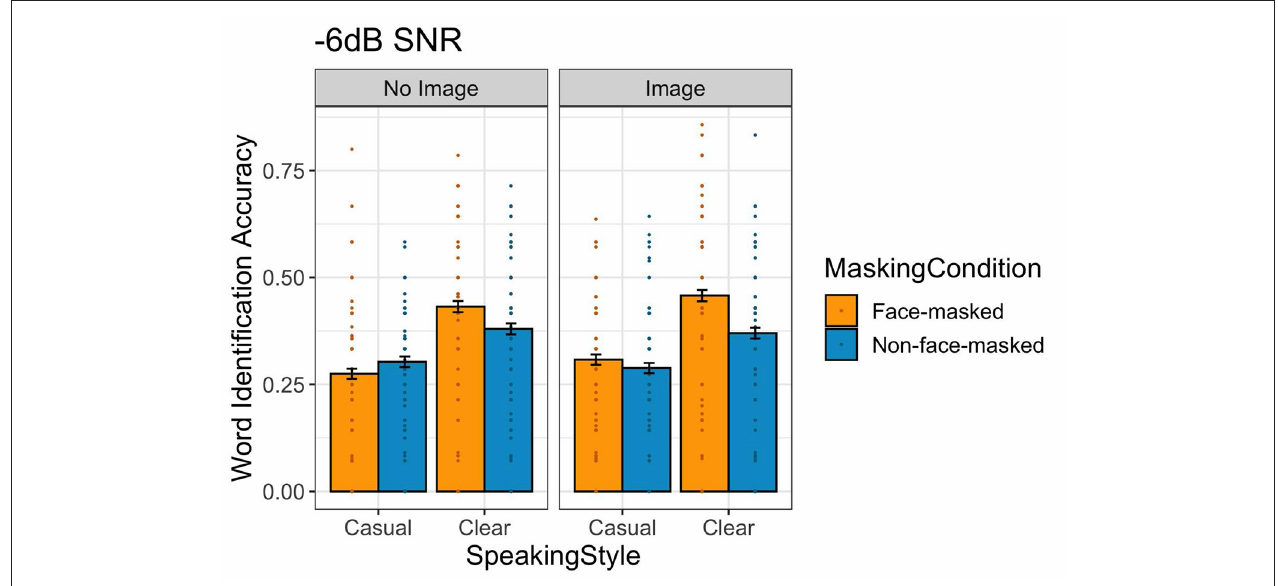
FIGURE 3 | (Color online) Target word identification accuracy for Experiment 1, − 6 dB SNR. The bars show the mean for each speech style, face-masking, and image condition. The error bars indicate standard errors of the mean. Individual points show mean accuracy for each participant across